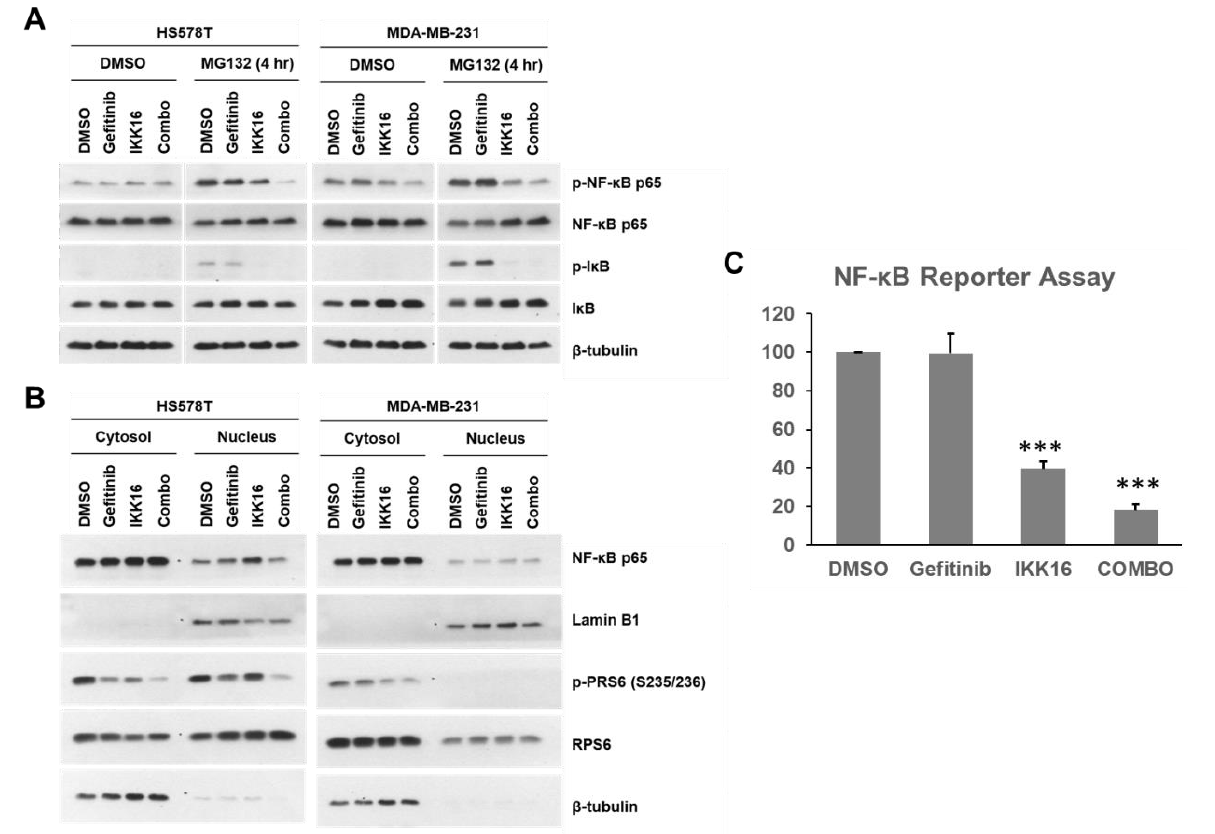
Figure 5. Regulation of NF- κB p65 by the Gefitinib+IKK16 treatment. ( A ) Proteasomal degradation of NF- κB p65/RelA by the Gefitinib+IKK16 treatment in the absence or presence of MG132. The cells were treated with drugs for 24 h as indicated. MG132 (10μ M) was applied for 4 h before treatment of drugs. ( B ) Subcellular localization of NF- κB p65/RelA and RPS6. The cells were treated for 24 h and the cytoplasmic and nuclear fractions were subjected to western blot analysis. Either β -tubulin or Lamin B1 was used as a loading control. Representative images were shown from three inde- pendent experiments. ( C ) NF- κB reporter gene assay. HS578T cells transfected with the NF - κB re- porter gene were treated with DMSO, gefitinib 5 μM), IKK16 (1.25 μM), or Gefitinib+IKK16 (5 μM and 1.25 μM, respectiv ely) for 24 h and luciferase activities were determined. Data from three inde- pendent experiments are shown as the mean ± SEM. ***, p < 0.005.